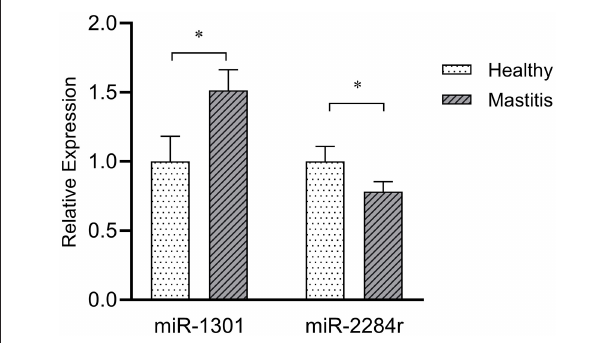
FIGURE 7 | Quantitative polymerase chain reaction (qPCR) verification of differentially expressed microRNA (miRNAs) obtained by RNAseq analysis.